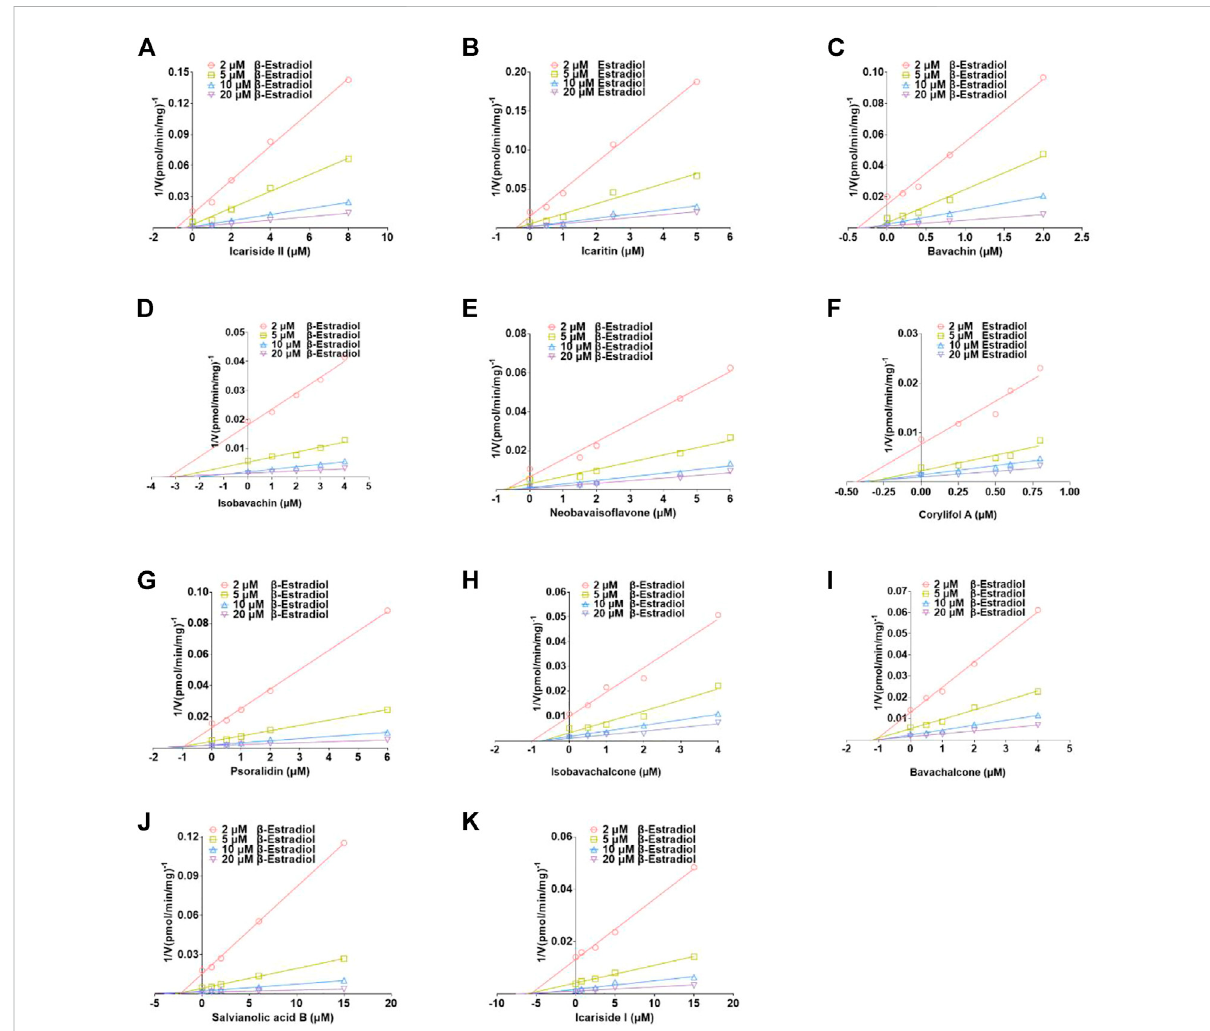
FIGURE 5 Dixon plots for the inhibitory effects of icariside II (A) , icaritin (B) , bavachin (C) , isobavachin (D) , neobavaiso fl avone (E) , corylifol A (F) , psoralidin (G) , isobavachalcone (H) , bavachalcone (I) , salvianolic acid B (J) , and icariside I (K) against β -estradiol-3- O -glucuronidation for UGT1A1. All data represent the mean ± SD of triplicate